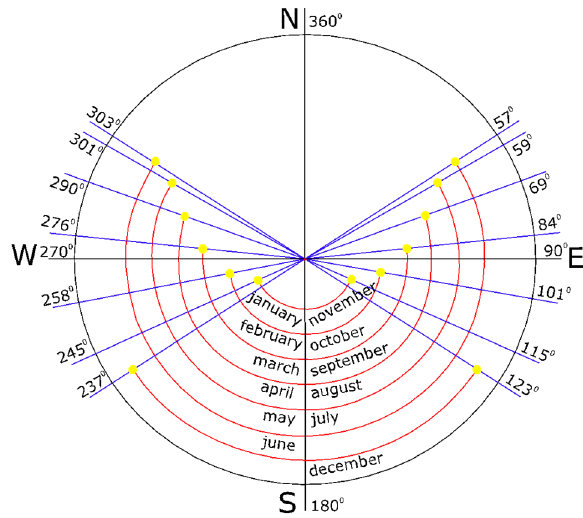
Figure 1. Azimuthal angles of the Sun’s movement during each month.